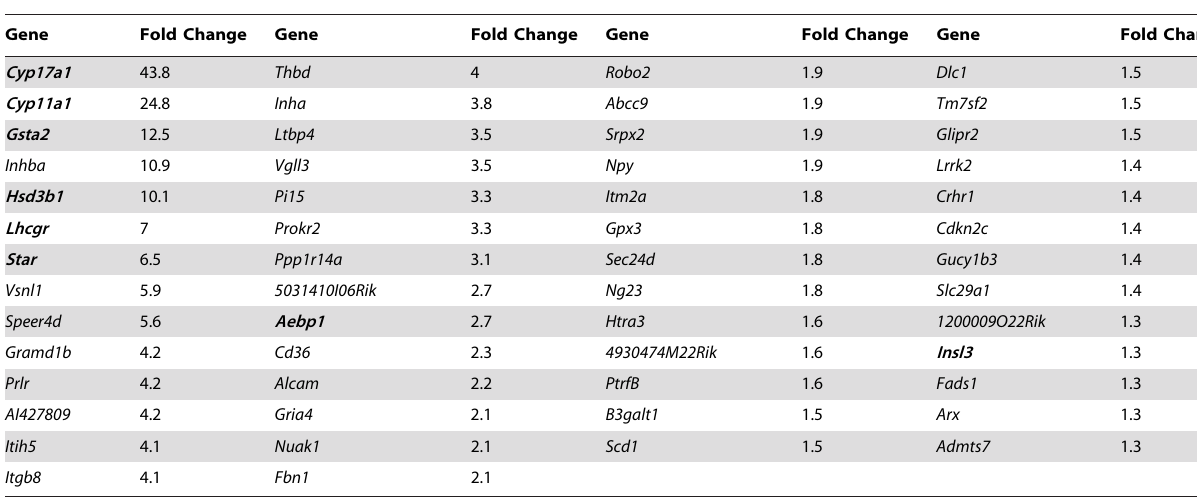
Table 2. List of genes highly enriched in fetal Leydig Cells.